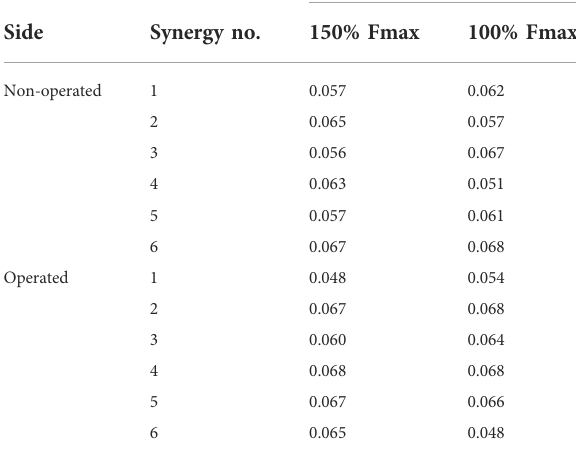
TABLE 7 Root-mean-square (RMS) differences between pre-surgery and predicted post-surgery synergy activations. Percentage of Fmax indicates the percent of pre-surgery psoas peak isometric strength used to generate the post-surgery walking prediction. RMS difference (unitless) Synergy